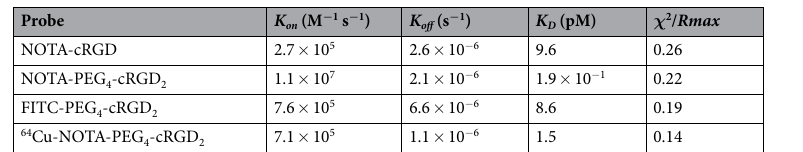
Table 1. Summary of binding affinity and kinetic rates measured between cRGD-based monomeric and dimeric probes and immobilized integrin α V β 3 receptor using a surface plasmon resonance-based approach. Kinetic constants were obtained by performing global kinetic analysis using the BIAevaluation software across several kinetic binding sensograms for each ligand-receptor